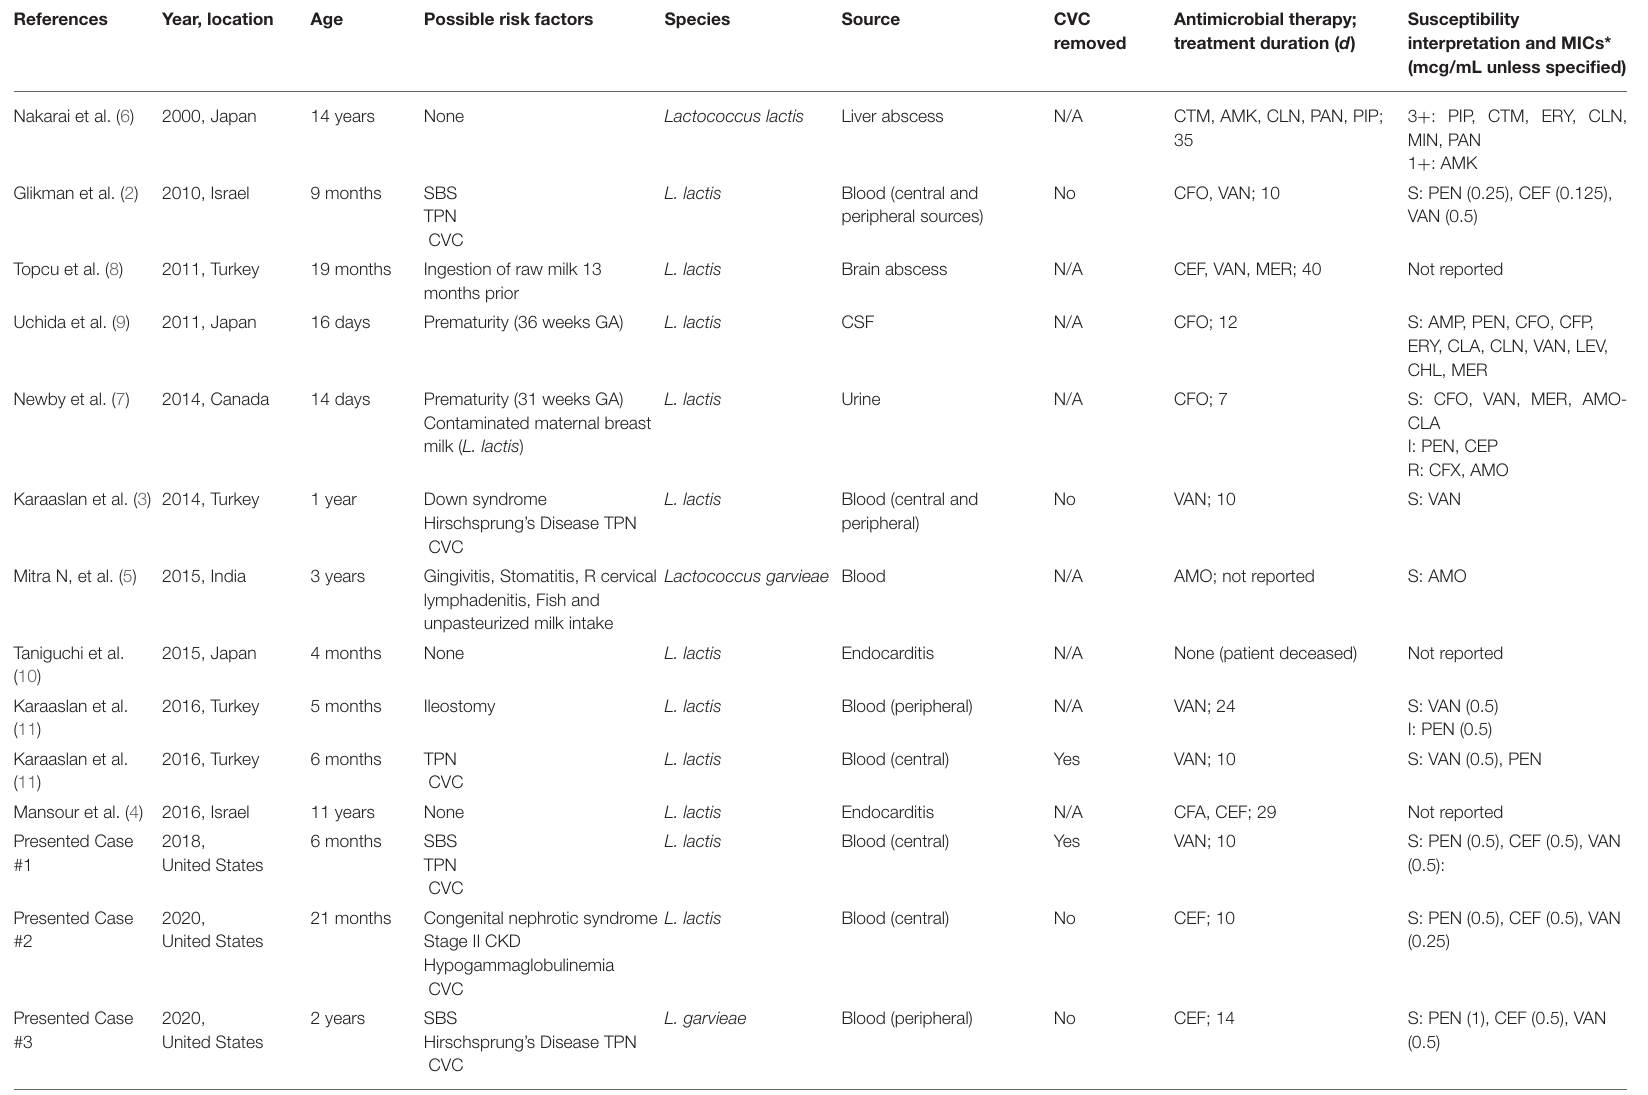
TABLE 1 | Cases of Lactococcus spp. infections in pediatric patients ( < 18 years of age) in English, peer-reviewed literature since 2000 in PubMed